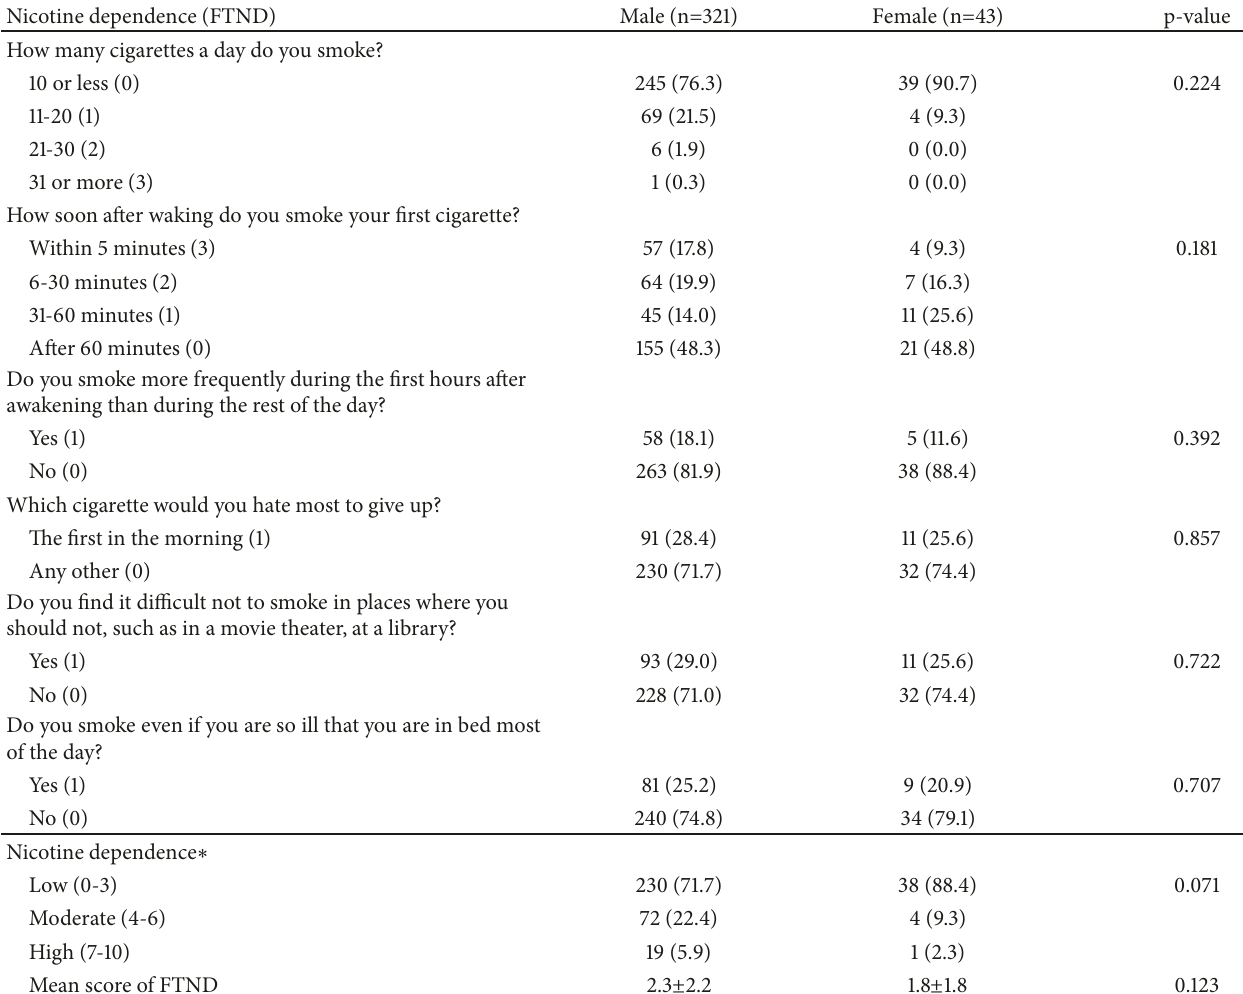
Table 3: Differences of nicotine dependence as measured by the Fagerstrom Test for Nicotine Dependence (FTND) between males and females